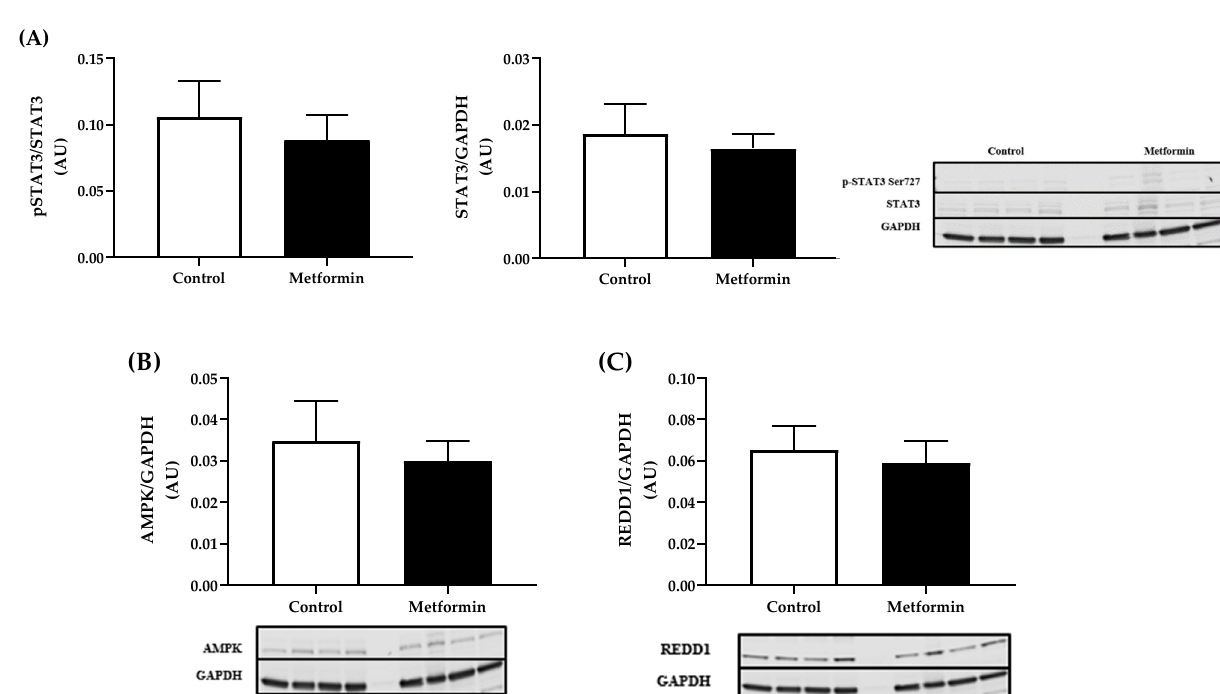
Figure 8. Protein expression in gastrocnemius muscle from C57BL/6J mice with orthotopically implanted with LL/2 non-small lung cancer cells. ( A ) STAT3 expression in gastrocnemius muscle from C57BL/6J mice with NSCLC. Phospho (p)- Signal transducer and activator of transcription 3 (STAT3) Ser727/Total STAT3 and STAT3/GAPDH expression (arbitrary units, AU) in gastrocnemius muscle from C57BL/6J mice with NSCLC concomitant with or without metformin (250 mg/kg) treatment. Data were analyzed using an unpaired t -test. ( B ) AMPK expression in gastrocnemius muscle from C57BL/6J mice with NSCLC. Total adenosine monophosphate-activated protein kinase (AMPK)/GAPDH expression (arbitrary units, AU) in gastrocnemius muscle from C57BL/6J mice with NSCLC concomitant with or without metformin (250 mg/kg) treatment. Data were analyzed using an unpaired t -test. ( C ) REDD1 expression in gastrocnemius muscle from C57BL/6J mice with NSCLC. Regulated in development and DNA damage responses 1 (REDD1)/GAPDH expression (arbitrary units, AU) in gastrocnemius muscle from C57BL/6J mice with NSCLC concomitant with or without metformin (250 mg/kg) treatment. Data were analyzed using an unpaired t -test. Sample size: Control, n = 7; metformin, n = 8. Data shown as mean ±